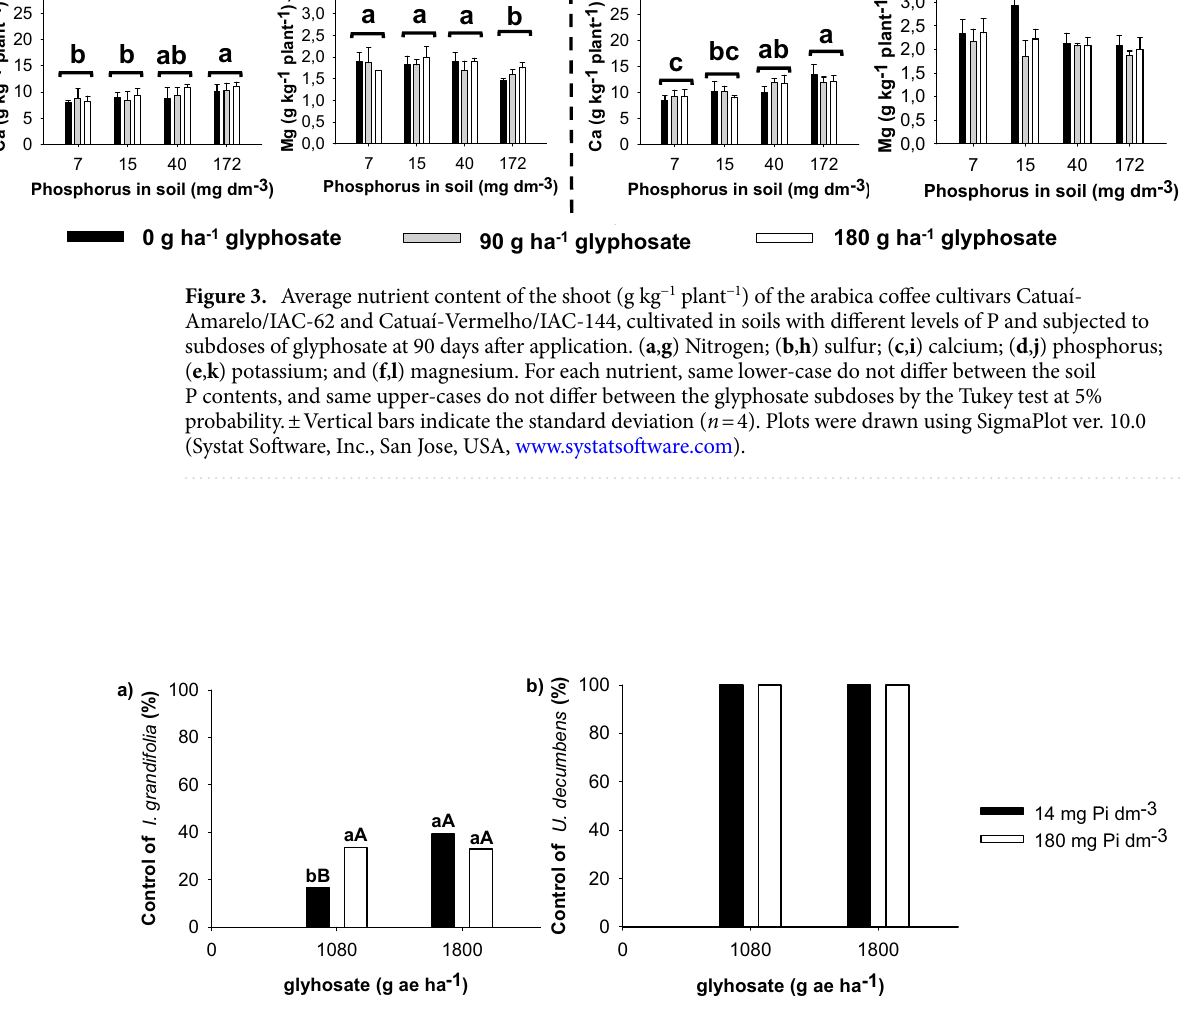
Figure 4. Control percentage of Ipomoea grandifolia ( a ) and Urochloa decumbens ( b ) plants cultivated in soils with 14 and 180 mg Pi dm −3 and submitted to doses of 0, 1080 and 1800 g ha −1 of glyphosate at 28 days after application (DAA). Means followed by the same lower-case do not differ between the soil P contents, and means followed by the same upper-case do not differ between the doses of glyphosate by the Tukey test at 5% probability. Plots were drawn using SigmaPlot ver. 10.0 (Systat Software, Inc., San Jose, USA, www. systa tsoft ware.